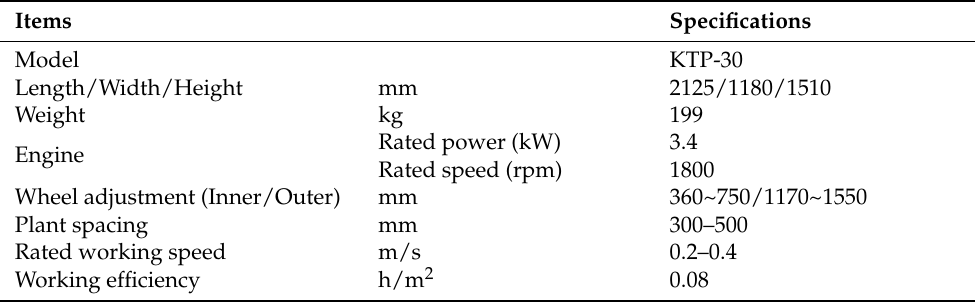
Figure 1. The shape of the 4-bar link type semi-automatic vegetable transplanter. Table 1. Specifications of the 4-bar link type semi-automatic vegetable transplanter.